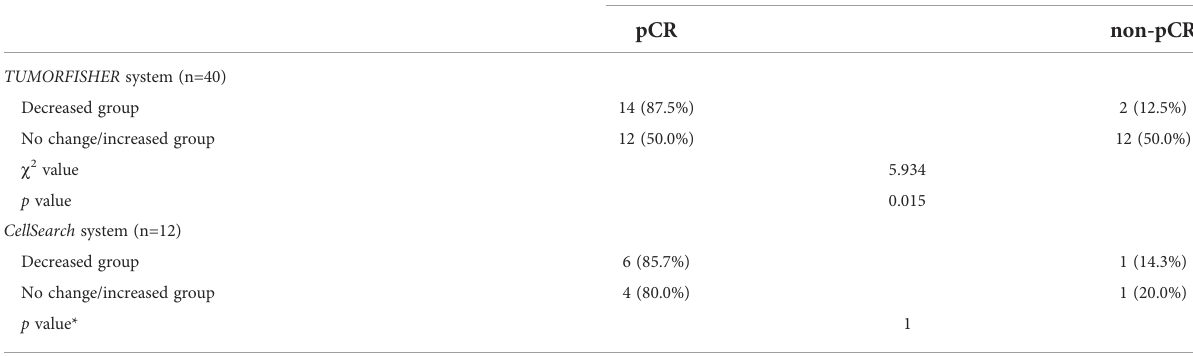
TABLE 5 The relationship between CTC dynamic changes and